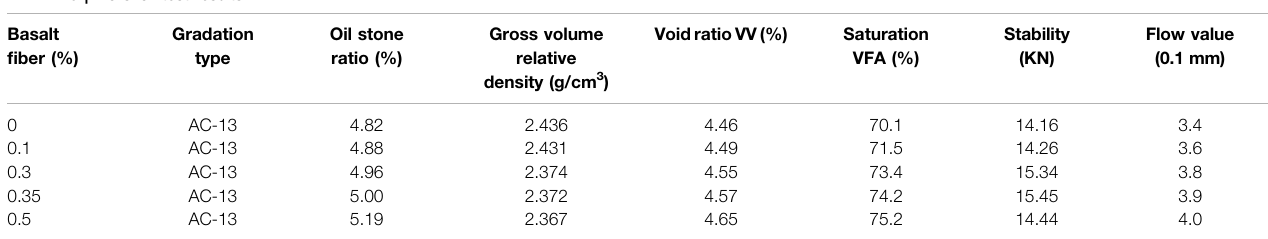
TABLE 5 | Marshall test results. Basalt fi ber